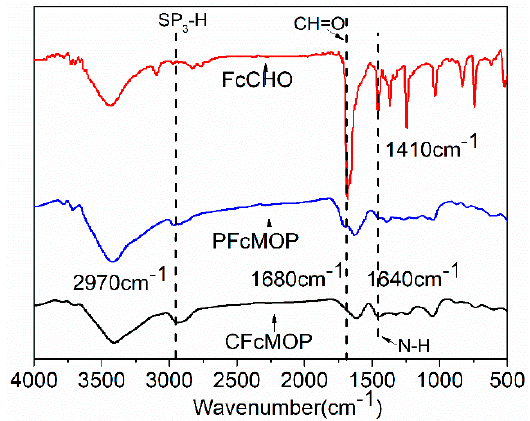
Figure 2. FTIR spectra of 1,1 ′ -ferrocenedicarboxaldehyde and the two ferrocenyl microporous polymers networks.